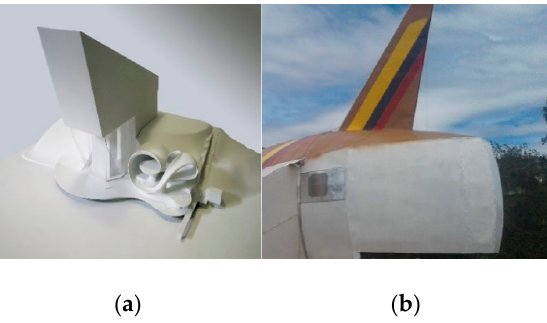
Figure 20. ( a ) Model where you can see the accesses and rest places at the bottom of the tail. ( b ) Frame of the tail of the plane before carrying out the high decoration of environments.